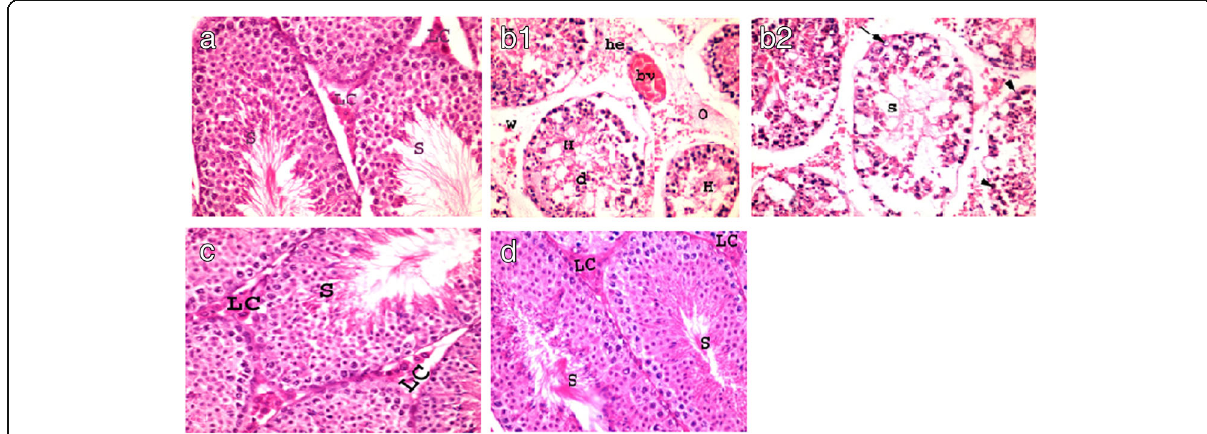
Fig. 4 A photomicrograph of testis sections. a Normal male Swiss albino mice showing normal histology of seminiferous tubules with complete spermatogenic layers (s). Leydig cells also showed normal appearance (LC). b1 Male Swiss albino mice treated with cadmium only showing seminiferous tubules with marked reduction of spermatogenic layers and absence of sperms (S), hyaline degeneration with esinophilic deposition, (H) and debris deposition in their lumen. Widened intertubuler areas (w) showed congested blood vessels with thickened hyalinized wall (b.v), with eosinophilia deposition (O), hemorrhage (he), and disappearances of Leydig cells (L). b2 Male Swiss albino mouse treated with cadmium only showing spermatocyte of seminiferous tubules with vacuolar nucleus (arrow) or pyknotic nucleus (arrow head). c Male Swiss albino mice treated with chocolate fortified with zinc nanoparticles showing normal seminiferous tubules with normal appearance of spermatogenesis, sperms, and Leydig cells. d Male Swiss albino mouse treated with cadmium and chocolate fortified with zinc nanoparticles showing normal histological structure of seminiferous tubules. Complete spermatogenesis and presence of sperm. Also, Leydig cells showed normal appearance (H & E X